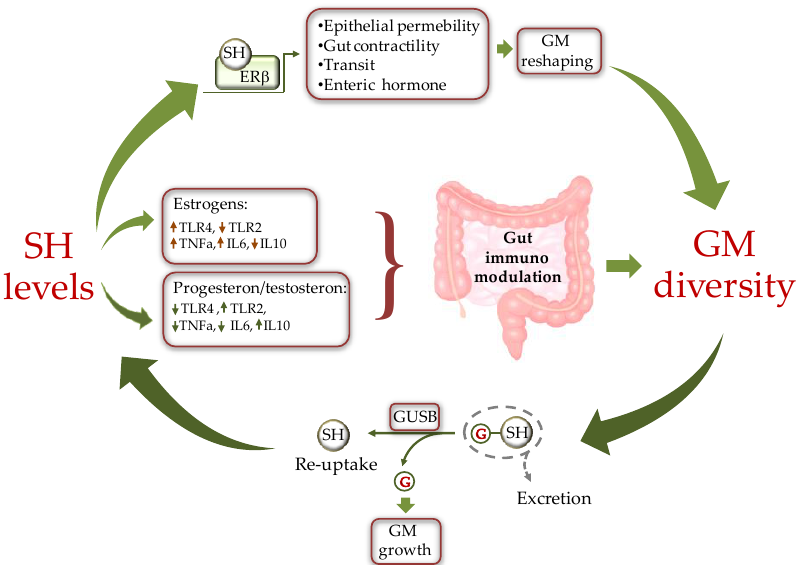
Figure 2. Schematic representation of the cross-talk between sex hormones (SH) and gut microbiota (GM). SH affect GM composition by modulating the intestine milieu via: (i) a direct gene expression regulation in epithelial cells; and (ii) by modulating the gut immune system through differential activation of TLRs. In turn, GM influences SH circulating levels by fine-tuning the balance between hormone excretion and reuptake. ER β = estrogen receptor beta, GUSB = β -glucuronidases; G = glucuronic moiety, IL = inteleukin, TLR = toll-like